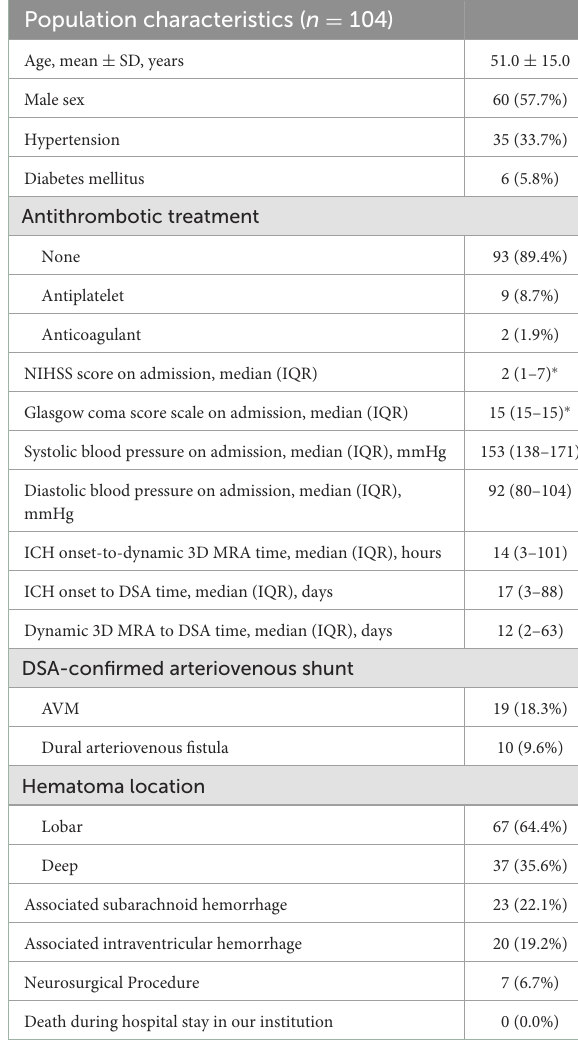
TABLE 1 Population